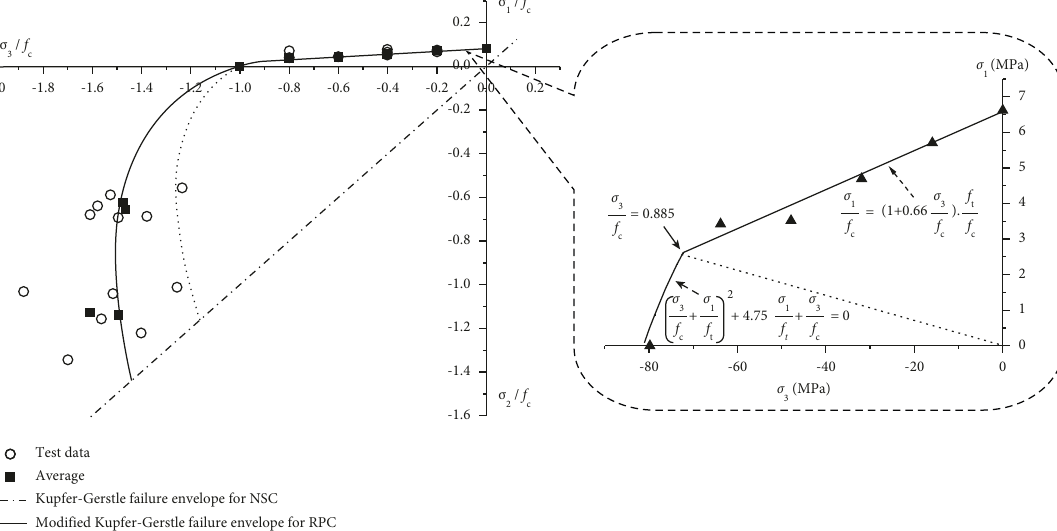
Figure 3: Failure envelope for RPC under biaxial stress.